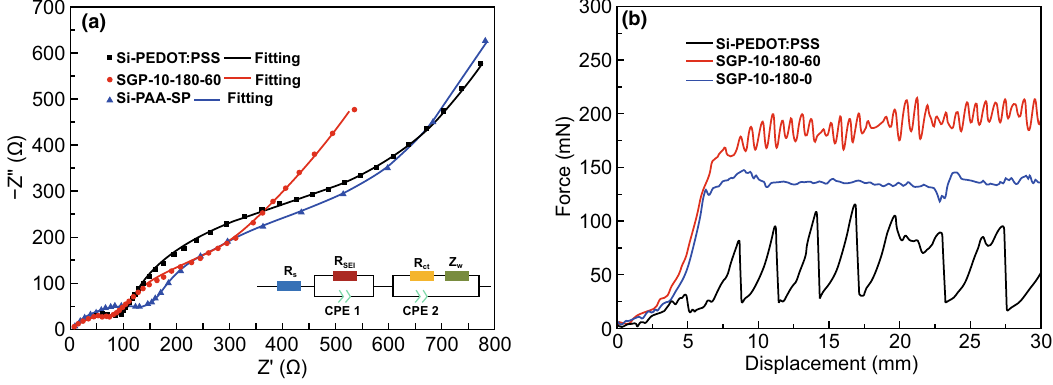
Fig. 4 a Nyquist plots of SGP-10–180-60, Si-PEDOT:PSS, and Si-PAA-SP anodes after 200 cycles at 1.0 A g -1 . b Peeling tests of the different electrodes. F-D relation of SGP-10-180-0, SGP-10-180-60, and Si-PEDOT:PSS